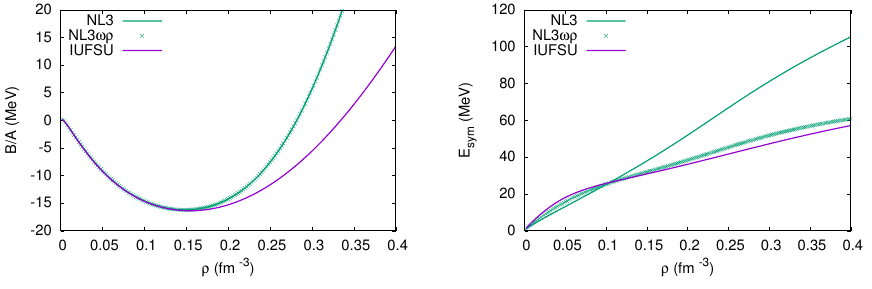
Figure 8. ( Left ) Binding energy and ( right ) symmetry energy as a function of the baryonic density for the three parameter sets used in this section. Table 2. Saturation and stellar properties. These values are commented along the text.